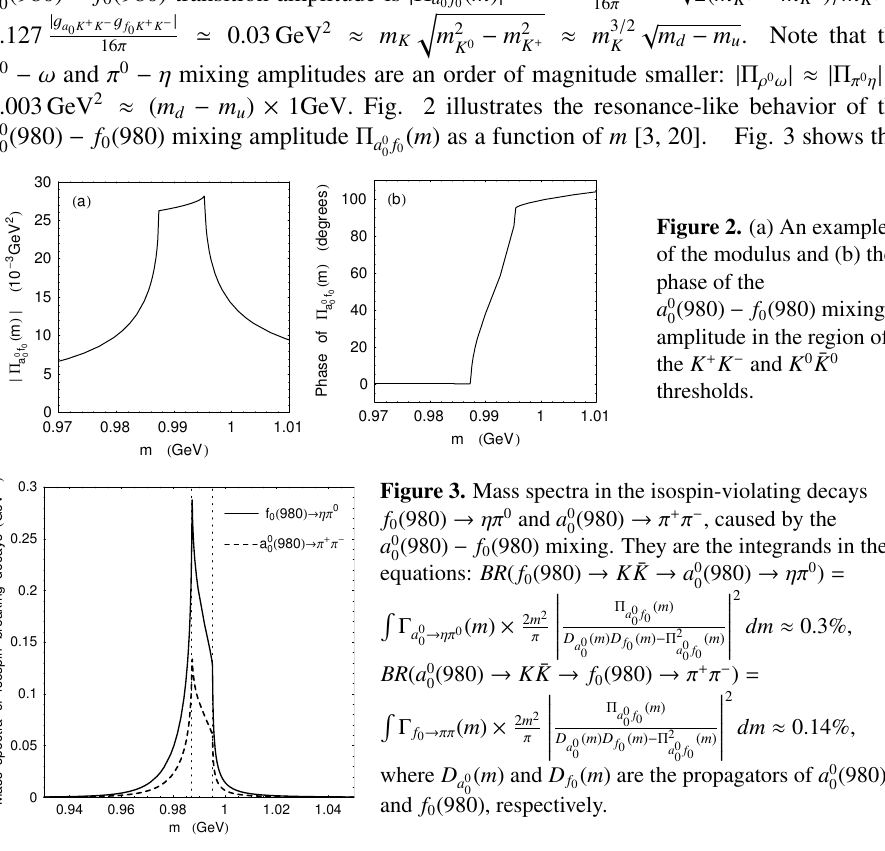
( m ) are the propagators of a 0 0